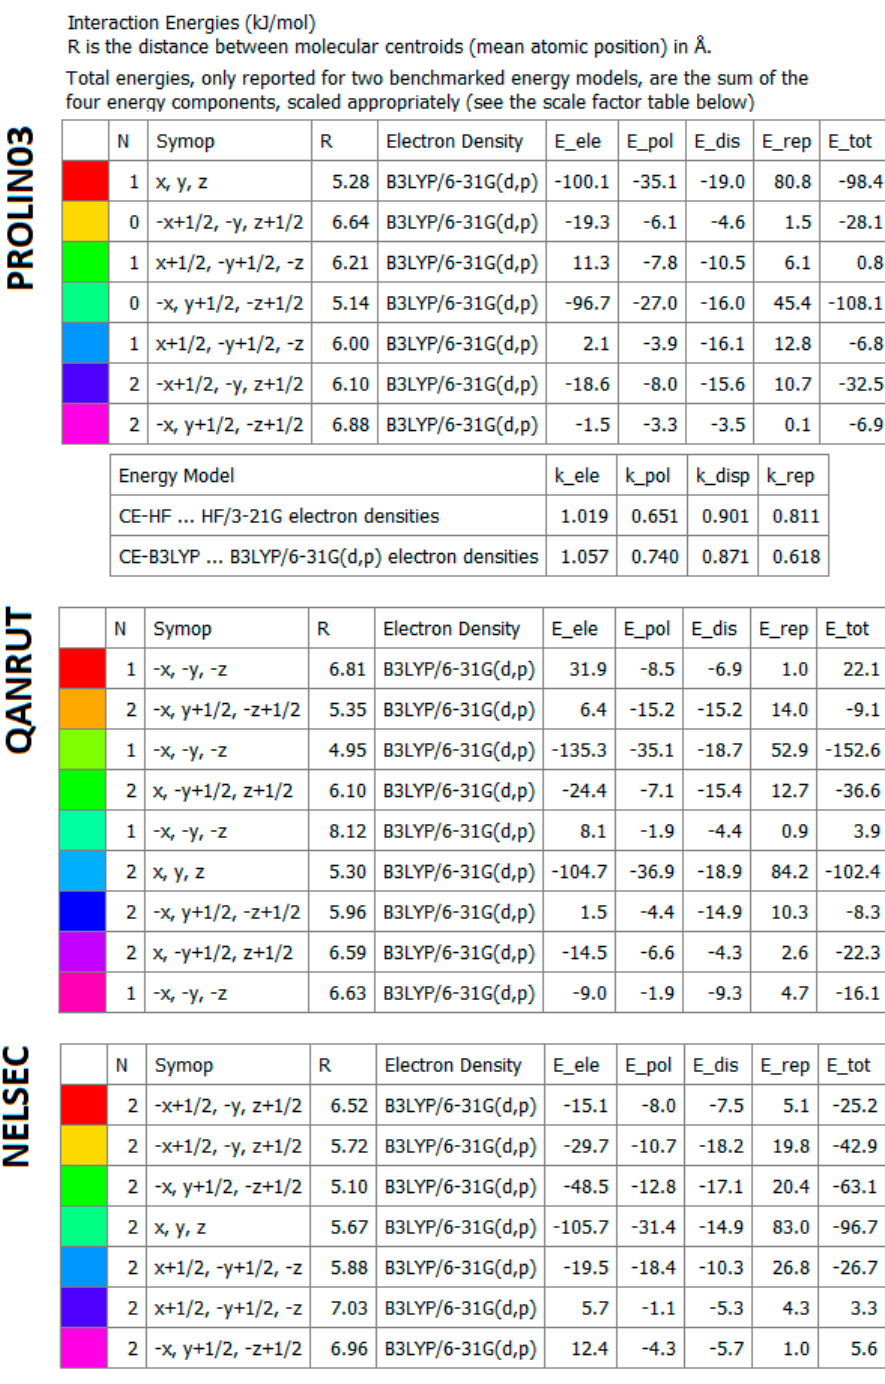
Figure 18. Interaction energies of the molecular pairs related to the energy frameworks of proline structures (scale factors for benchmarked energy models).